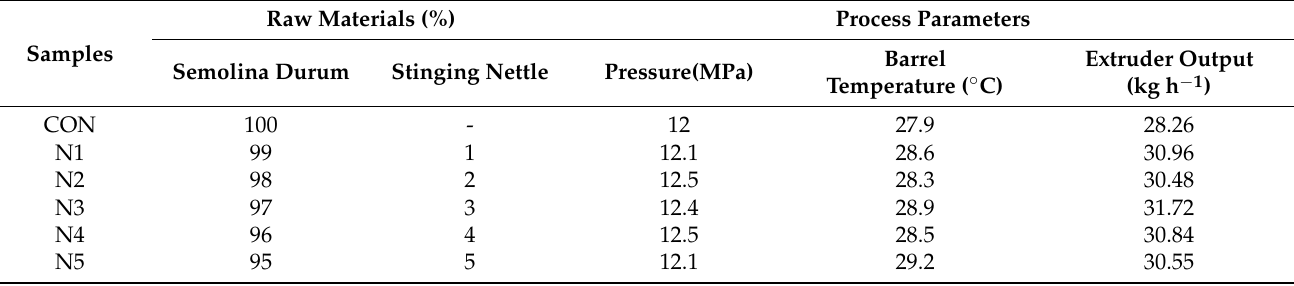
Table 1. The parameters of pasta